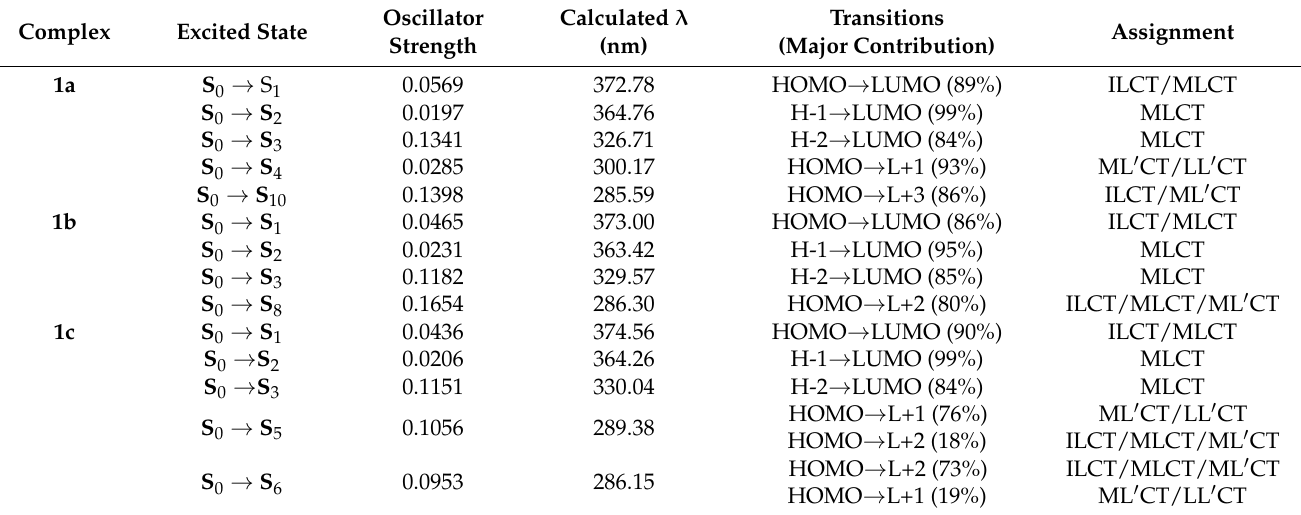
Table 1. Wavelengths and nature of transitions of 1a – c (M = Pt, L = Vpy, L (cid:48) = PR 3 ).